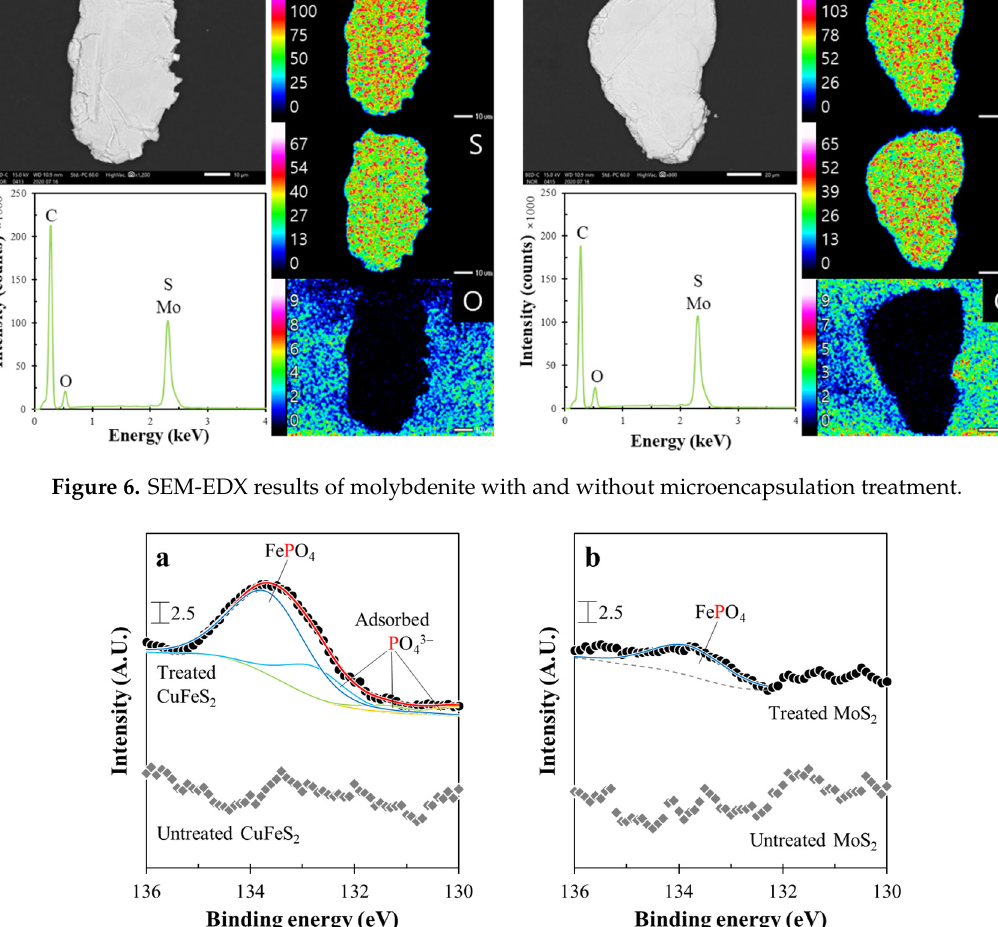
Figure 7. X-ray photoelectron spectroscopy (XPS) P 2p spectra of ( a ) chalcopyrite and ( b ) molybdenite with and without microencapsulation treatment.